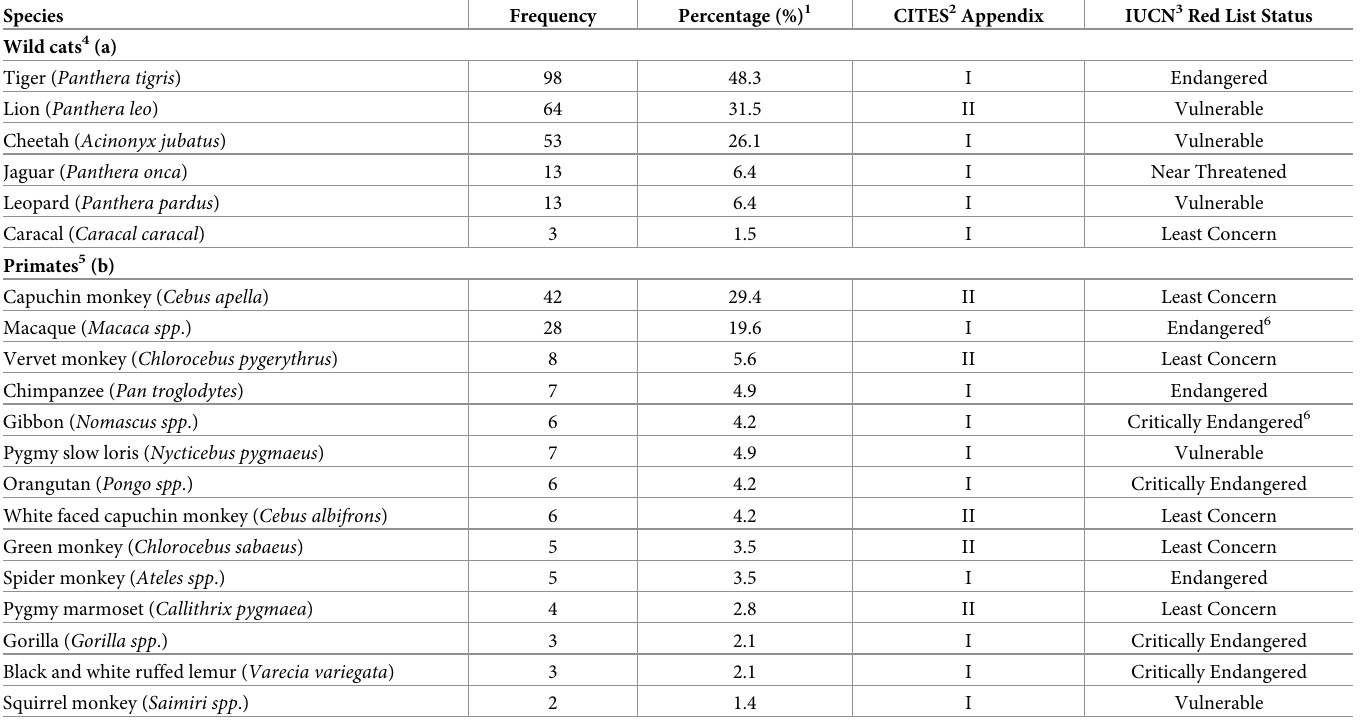
Table 1. Species representation and associated conservation status. The number of instances and percentage of corresponding YouTube 1 videos published between 2006 and 2019 associated with search terms explored, wherein key exotic wild cat (a, n = 203) and primate (b, n = 143) species were identified. A multiple response analysis was considered as some videos featured multiple species. The frequency describes the number of videos in which each species appeared, whereas the percentage represents the number of videos each species appeared in as a percentage of all wild cat or primate videos. Instances where primate or exotic wild cat videos featured more than one associated species have been included. Species with a frequency equal to or less than one have been excluded from the table.